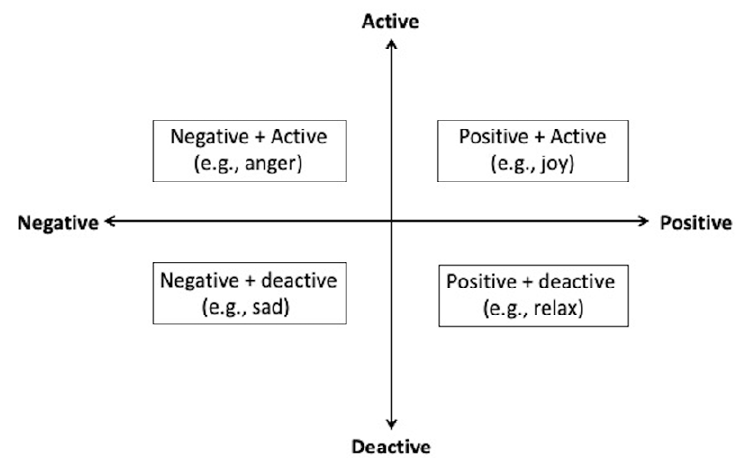
Figure 2. Category of emotion items.